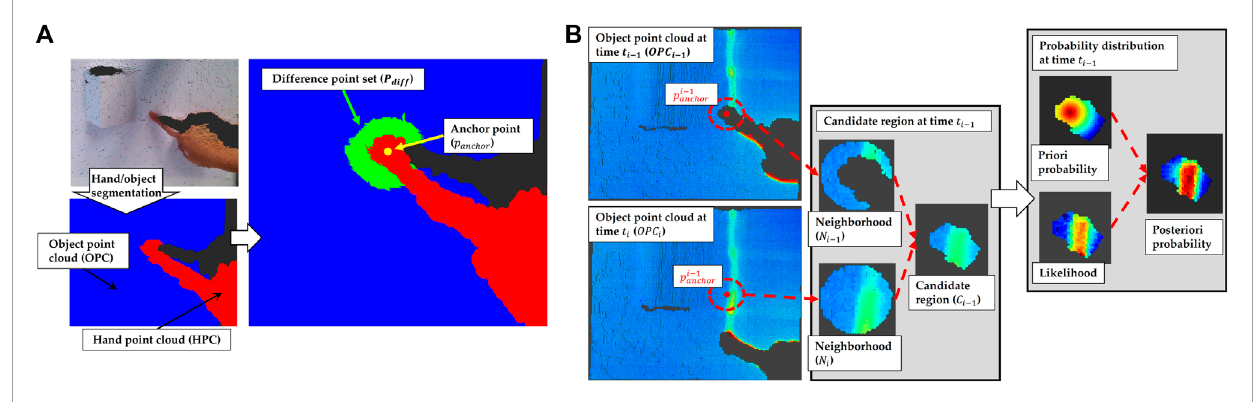
FIGURE 3 (A) : hand/object segmentation and the method for defining anchor points ( P anchor ) (B) : the concept to define the candidate region ( C i ) and a visualization of the prior probability ( P prior ) , likelihood ( L ) and posterior probability ( P posterior ) .